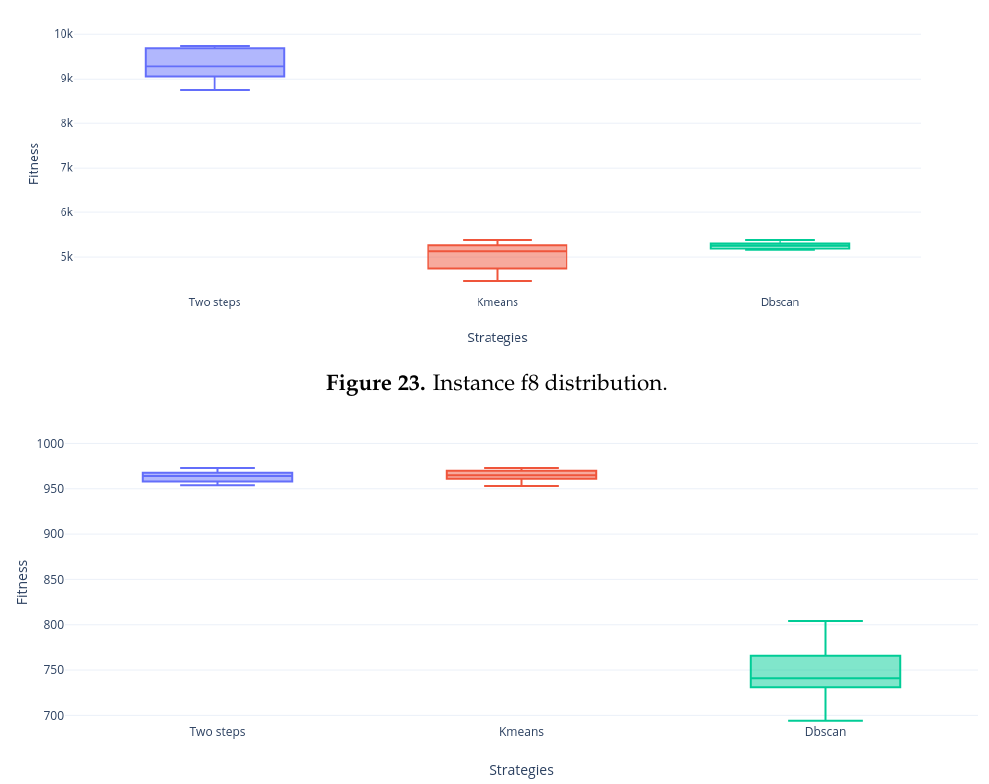
Figure 24. Instance f10